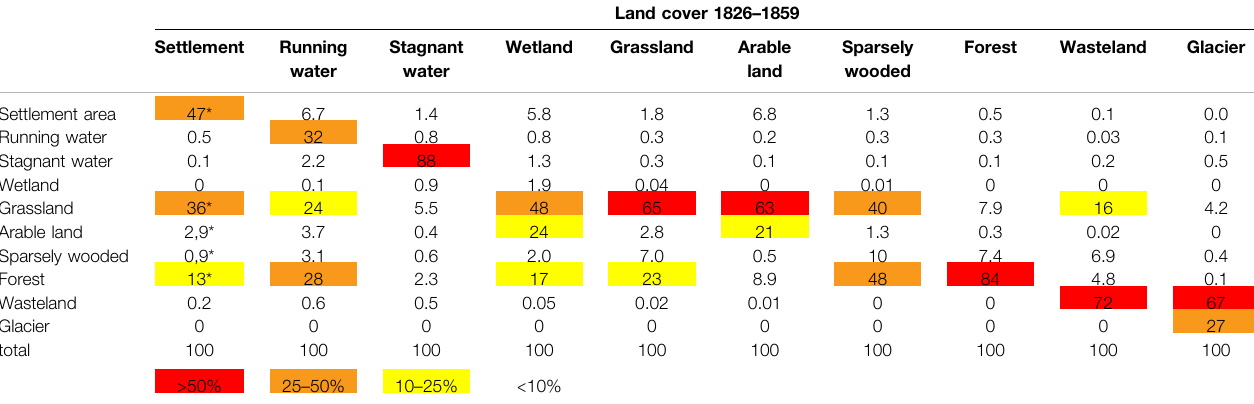
TABLE 2| Matrix ofland cover transformation: percent shares ofland cover classes 1826 – 1859(upper row) that changed to other classes by 2016(columns). Values along the diagonal from settlement/settlement to glacier/glacier represent unchanged shares. Color cells symbolize different intensities of land cover changes.